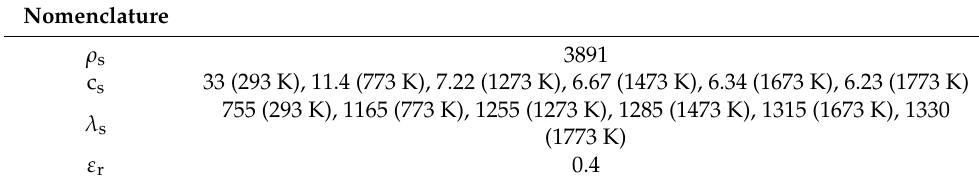
Table 1. Properties of Al 2 O 3 pellets